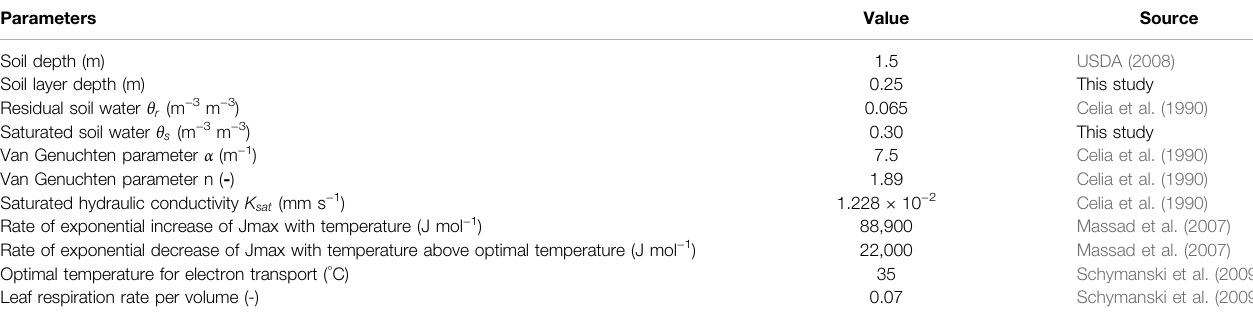
TABLE 2 | Soil and vegetation parameters. Parameters